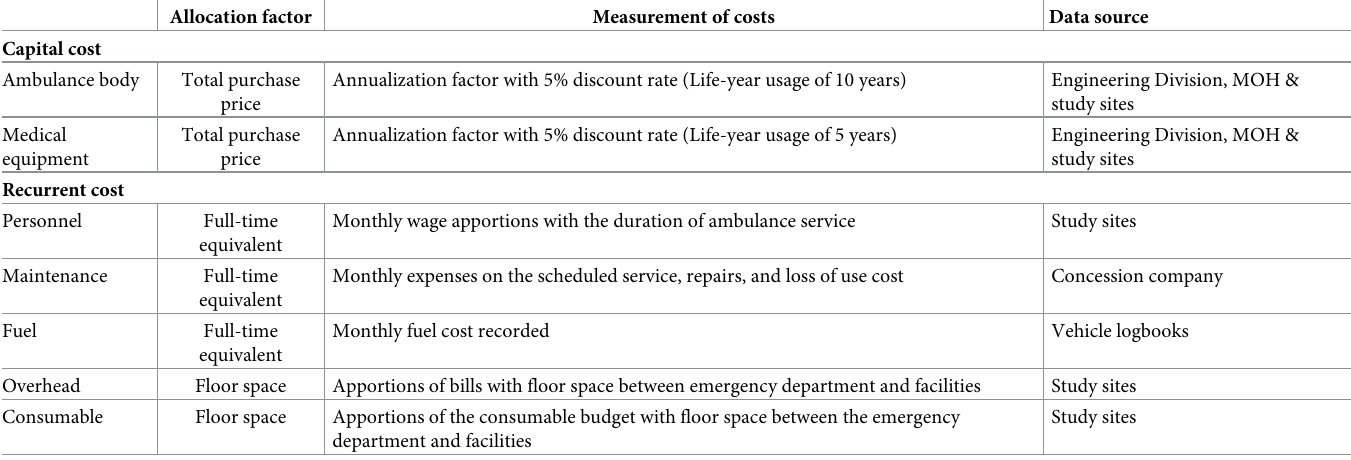
Table 1. Mixed top-down and activity-based costing (ABC)